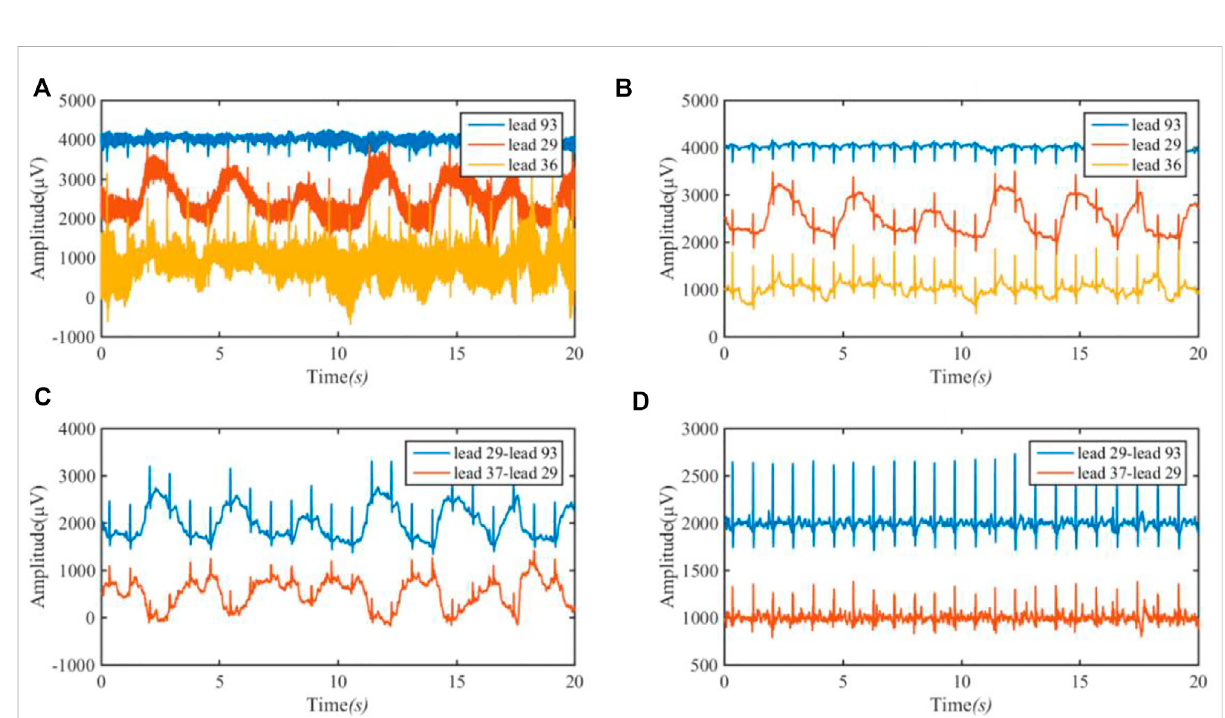
FIGURE 5 ECG of lead I (29 – 93) and lead III (37 – 29) achieved from BSPM. (A) the original BSPM. The blue line is 93 lead (channel); the red line is 29 lead (channel);andtheorangelineis36lead(channel). (B) TheECGafterband-pass fi ltering. (C) TheapproximateECGofleadIandIII.Thebluelineisthe approximateECGofleadIbysubtractinglead(channel)93amplitudefromlead(channel)29amplitude;theredlineistheapproximateECGofleadIII by subtracting lead (channel) 29 amplitude from lead (channel) 37 amplitude; (D) The signal after removing the baseline